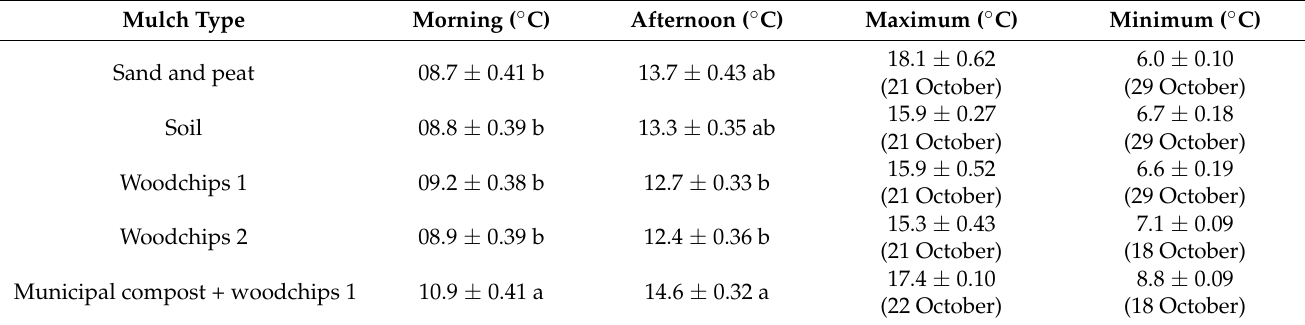
Table 1. Mean and daily maximum and minimum ( ± SEM) temperatures recorded 5 cm below the surface of mulches at 0900 h (morning) and 1500 h (afternoon) on 10 of 14 days (actual dates) of an outdoor microplot experiment at Agriculture and Agri-Food Canada research plots near Jordan Station, Ontario. Means within columns with the same letter are not significantly different (Tukey’s HSD test, α =